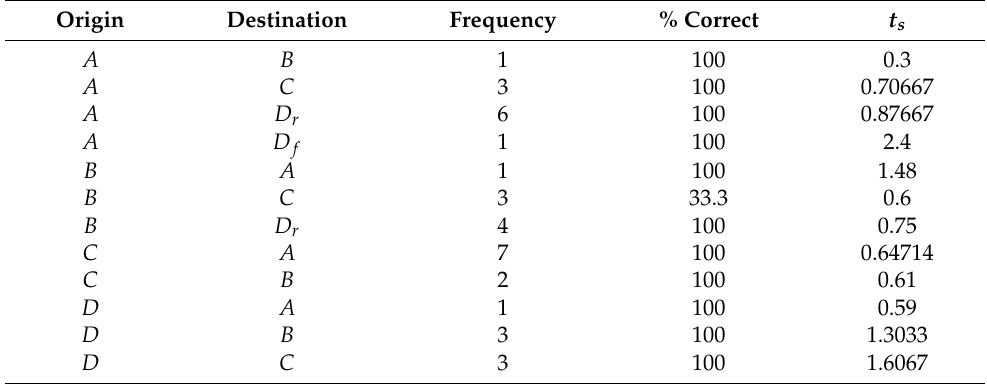
Table 3. Experimental results when testing on a single crossing as visualized in Figures 6 and